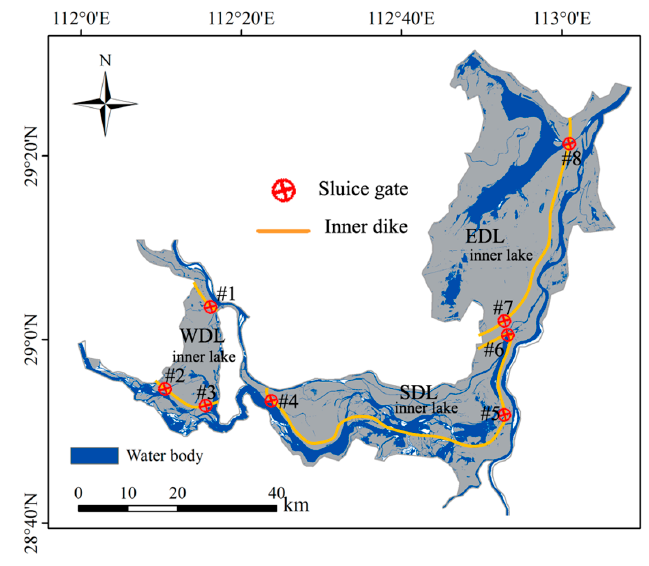
Figure 5. The layout of the IFCS in Dongting Lake.